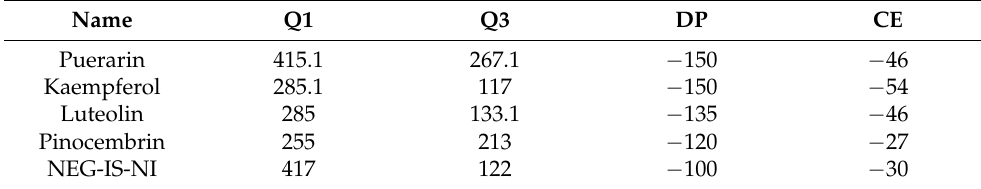
Table 8. The specific parameters of